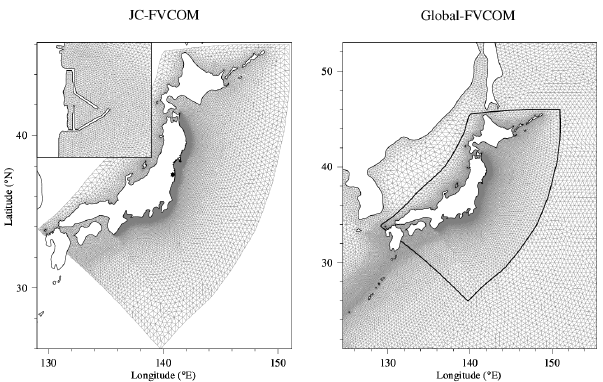
Fig. 4. A view of model grids for the global-Japan coastal nested FVCOM system used in this study. The Global-FVCOM grid cov- ers the entire global ocean with a horizontal resolution of 2km in the Japanese coastal region (shown in the right panel). The bold black line in the right panel indicates the nesting boundary that link Global-FVCOM and the Japan coastal FVCOM (JC-FVCOM). The left panel is an enlarged view of